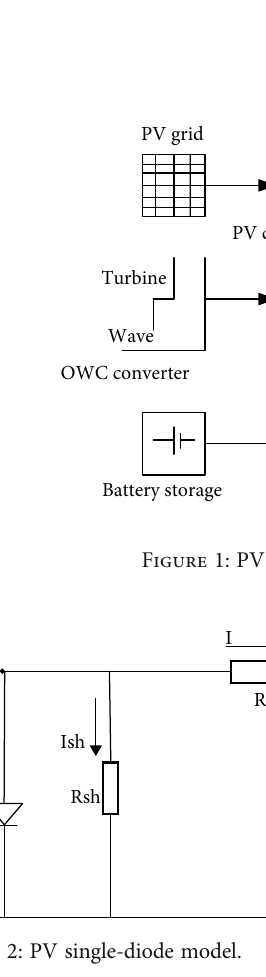
Figure 3: Model of